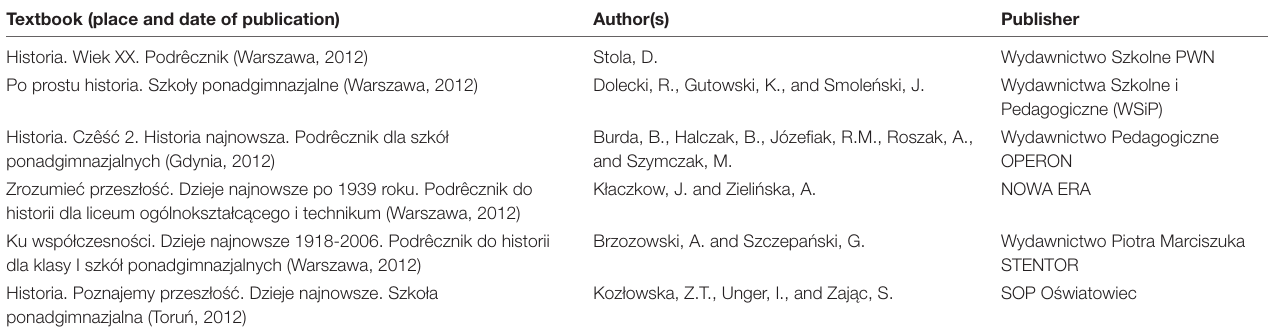
TABLE 1 | Secondary school textbooks selected for the